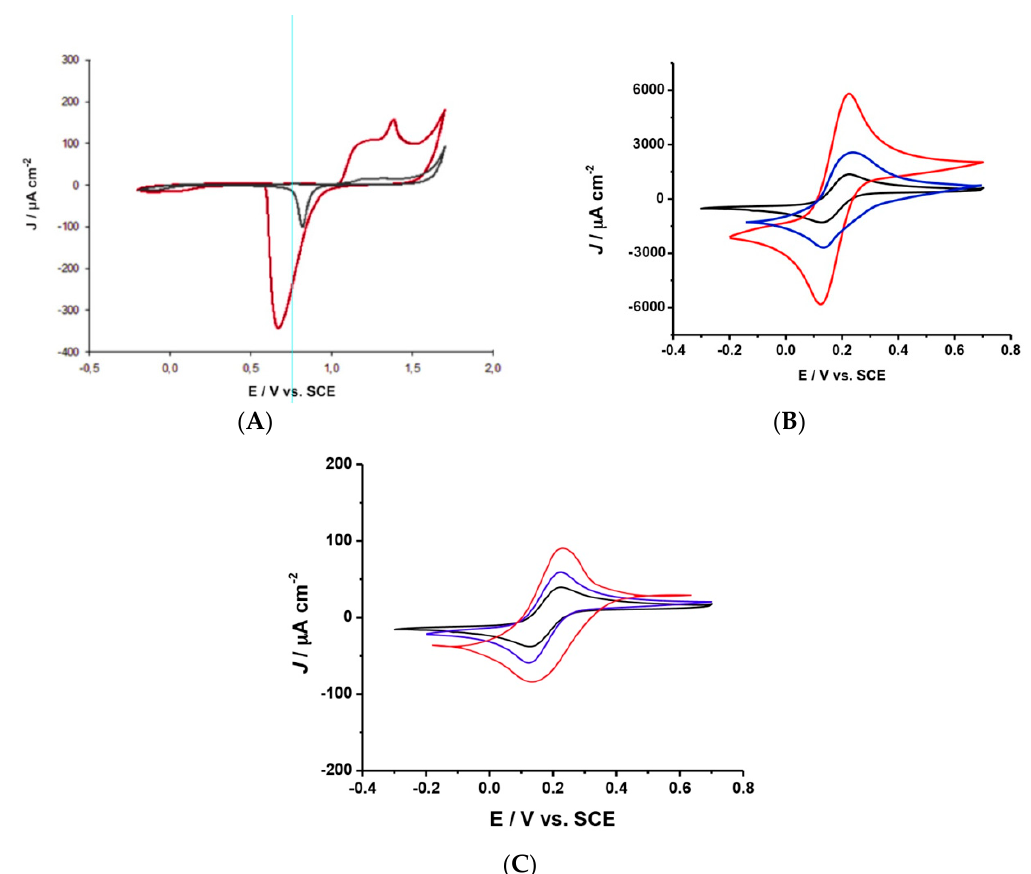
Figure 3. Cyclic voltammograms of: ( A ) the h-PG / Au microneedles electrode (red curve) and the bare Au / microneedles electrode (black curve) in H 2 SO 4 0.5 M, v = 100 mV s − 1 ; Au microneedles ( B ) and the Au planar electrode ( C ) unmodified (black) and after the electrodeposition of h-PG (red curves) and Au-multiwalled carbon nanotubes (MWCNTs) (blue curves) in 5 mM Fe(CN) 63 − / 4 − , 50 mM phosphate-bu ff ered saline (PBS) at pH 7.5, and 137 mM NaCl, v = 50 mV s − 1 , T = 25 °C.